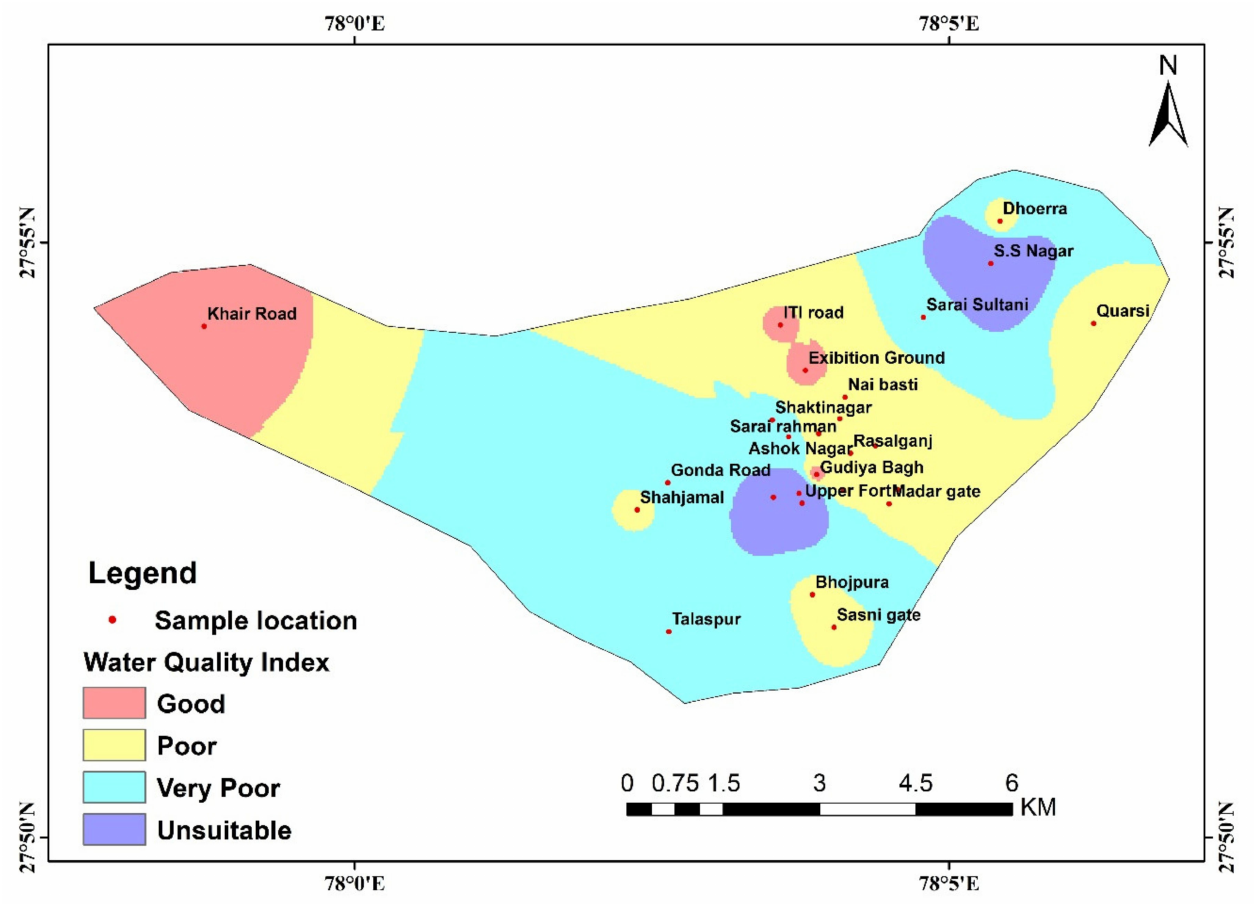
Figure 10. Water quality index of the study area in Aligarh